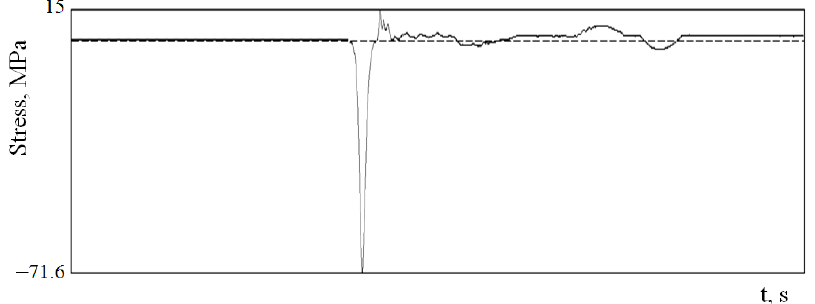
Figure 15. Maximum equivalent stresses (Strain gauge 2).